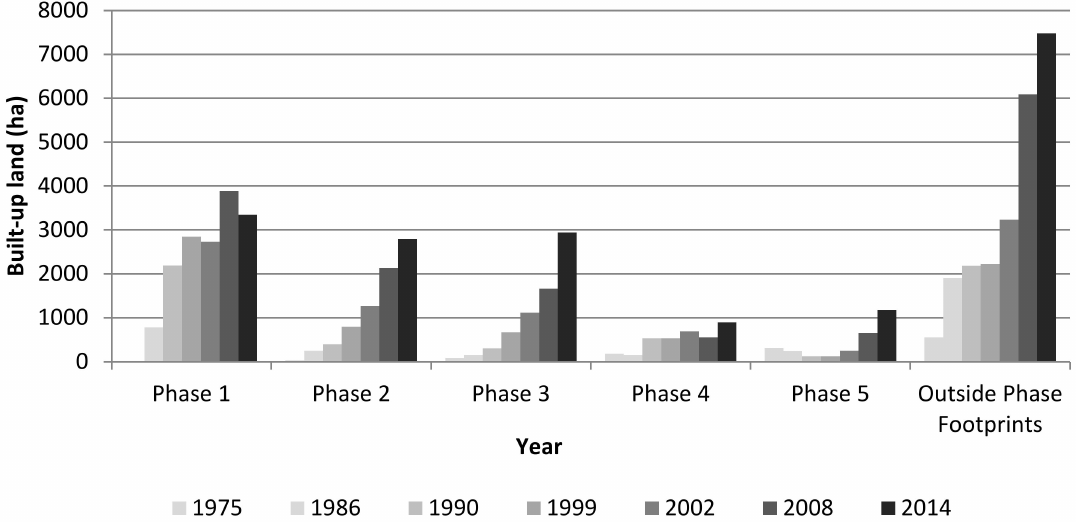
Figure 5. Increases in built-up land in Abuja both within the boundaries of the five Master Plan development phase areas and outside the overall Master Plan